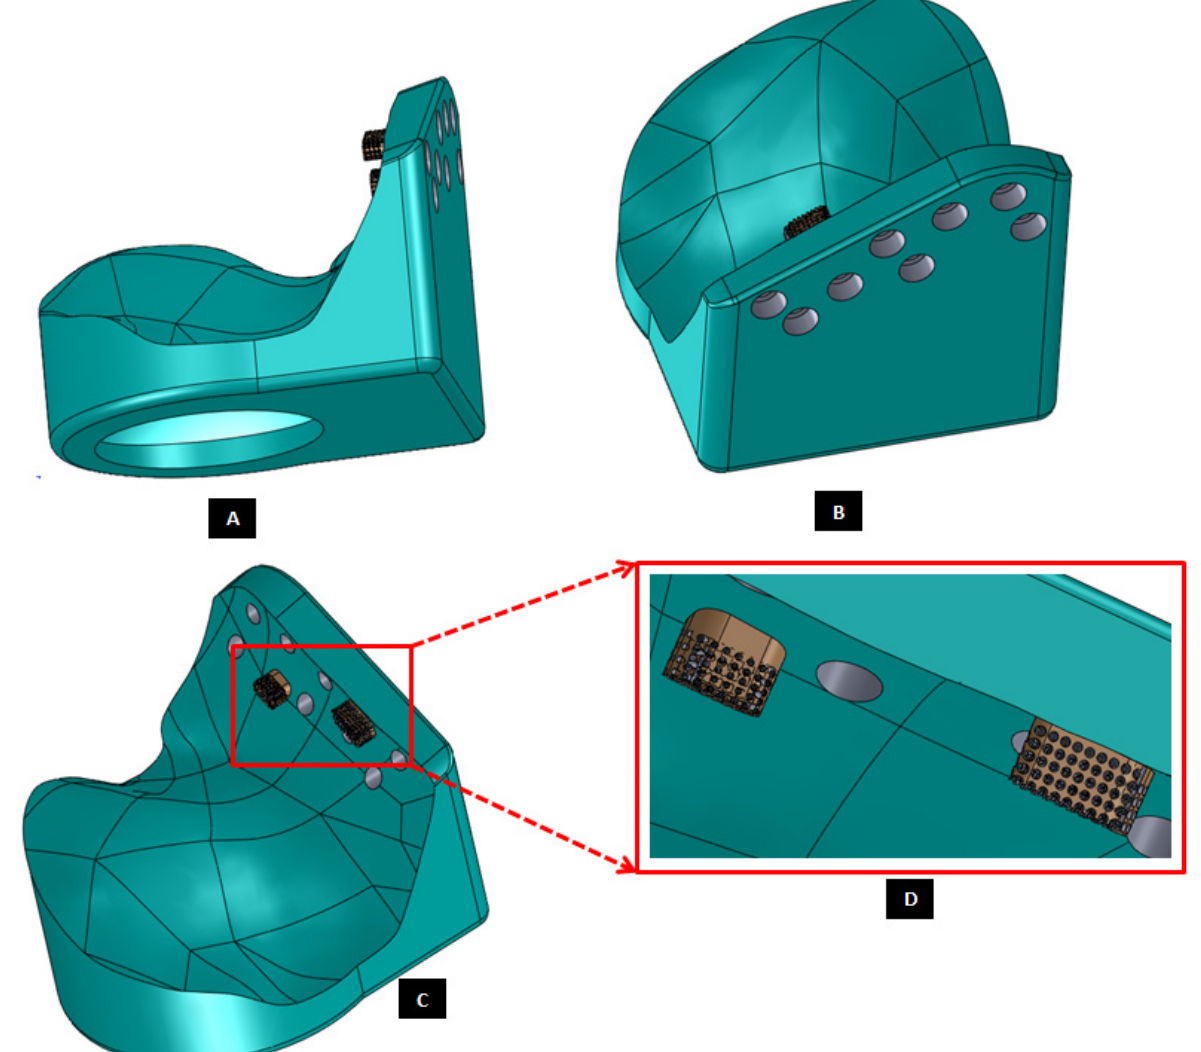
Figure 19. Patient-specific design of a fossa implant with circular articular surface/hole in the inferior face of the device ( A ). The device has a novel feature; perforated medial notches ( B ) protruding into host bone at implantation. Each perforated notch is designed to fit into surgically created mating grove in the host bone, thereby maximizing device stability by allowing ingrowth of bone into the prosthesis after implantation ( C , D ). The notches also provide a mode for load transfer between the prosthesis and native bone, thereby reducing the amount of load and resultant stress acting on the fixation screws. The surgeons can be provided with custom-designed templates and cutting guides to accurately cut the slots in native bone to accommodate perforated notches.